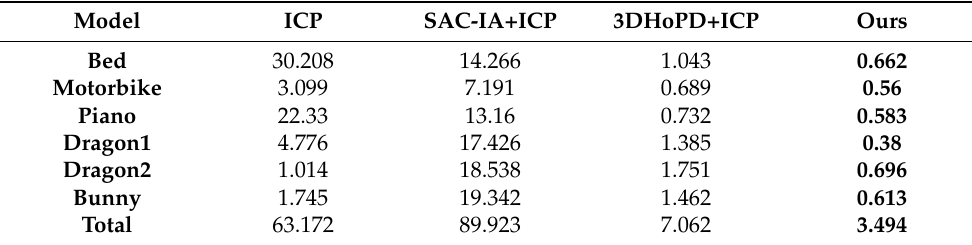
Table 6. Registration time for six models of each